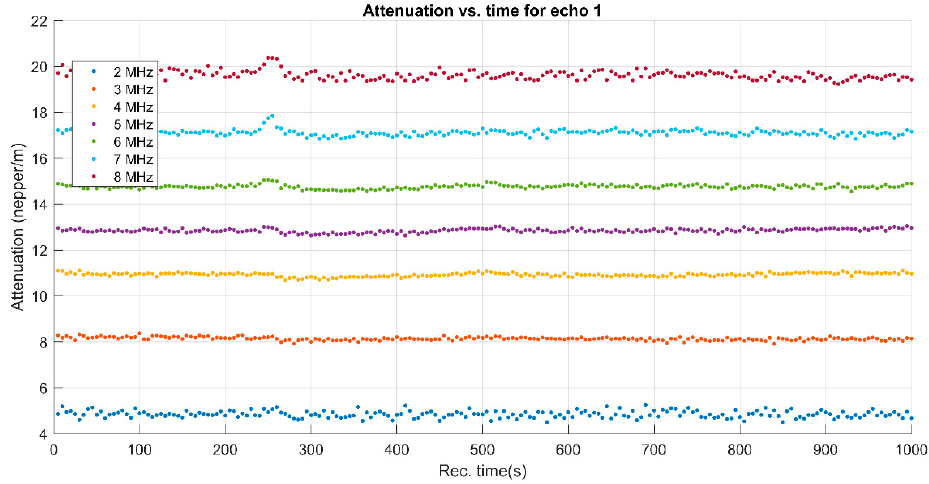
Figure 7. Spectral attenuation vs. time for first echo.